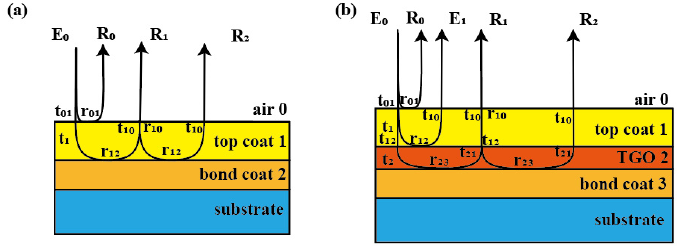
Figure 3. ( a ) Structure of the TBC before thermal cycle; ( b ) Structure of the TBC after thermal cycle.